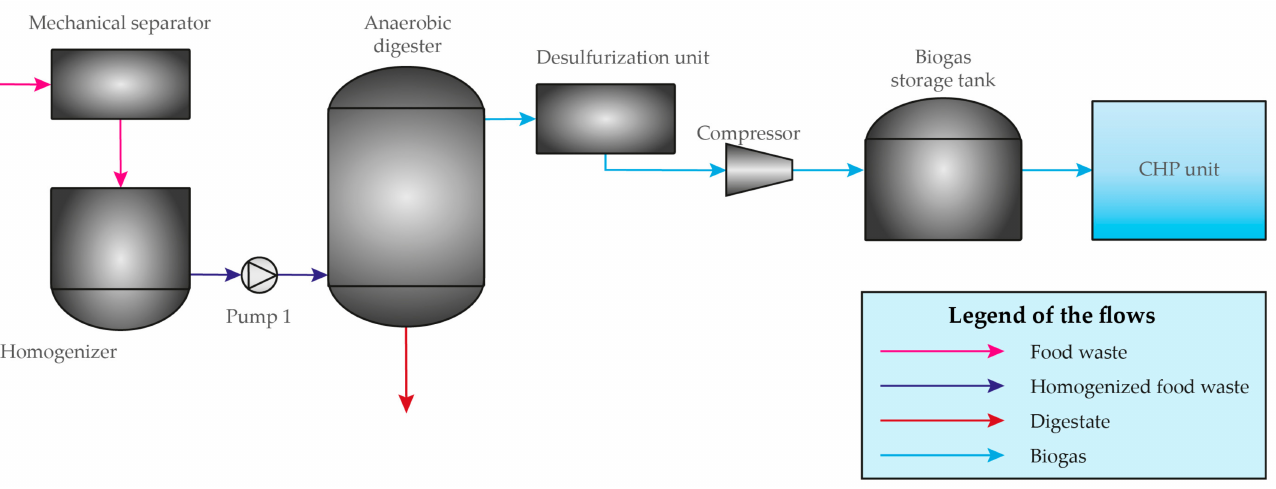
Figure 1. Scheme of the biogas production